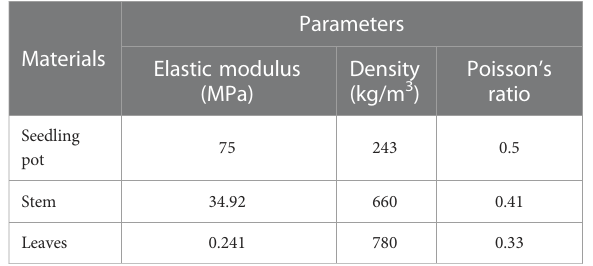
TABLE 1 Key parameters of the end-effector.